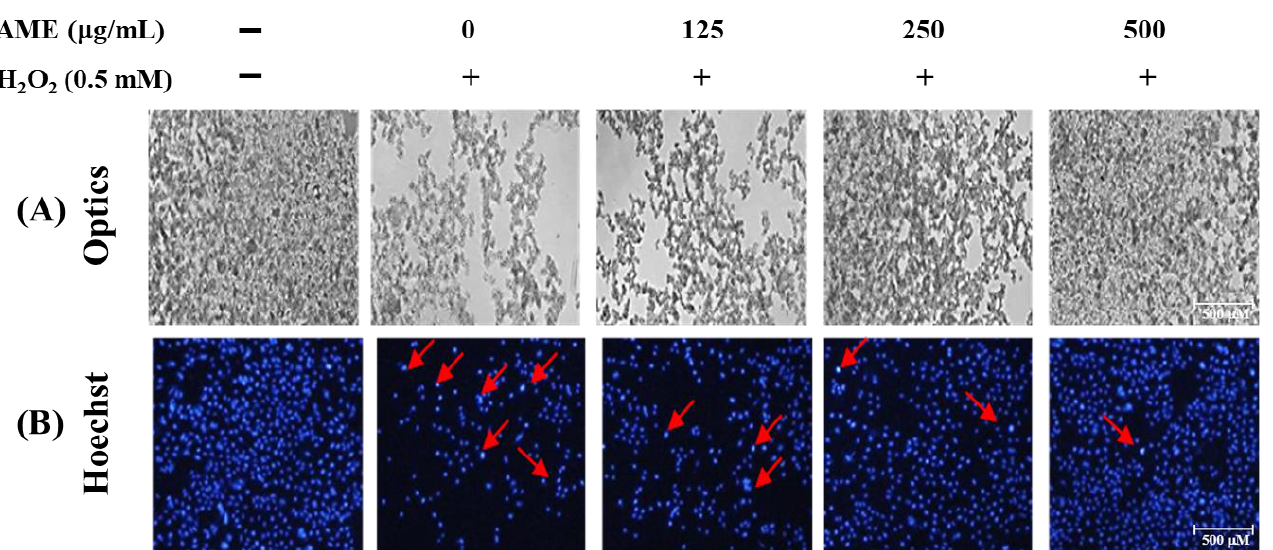
Figure 6. Changes in nuclear morphology of H 2 O 2 -stimulated PC12 cells under the AME pretreatment. The cells were first cultivated for 24 h, treated with AME for another 24 h, then stimulated with 0.5 mM H 2 O 2 for 4 h. ( A ) The cell morphology was observed by a phase-contrast microscope. ( B ) Nuclear changes were examined by Hoechst staining and observed with a fluorescence microscope. The arrows indicate nuclei with severe DNA damage.